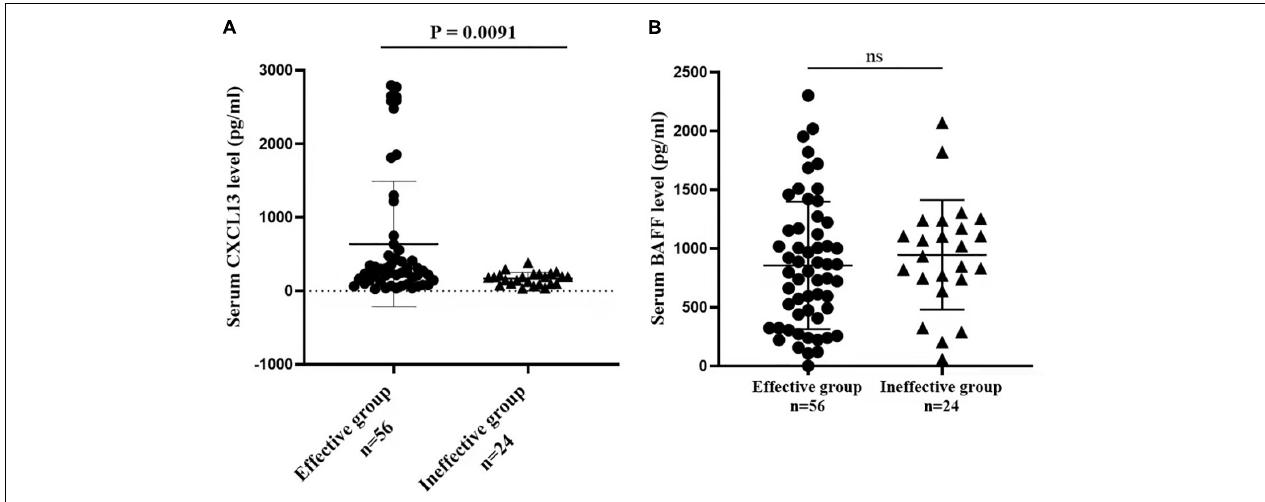
FIGURE 3 | Serum cytokines levels of CXCL13 and BAFF between the effective and ineffective groups. (A) The serum CXCL13 levels are significantly up-regulated in the effective group than the ineffective group ( P < 0.01). (B) No statistical difference is observed in serum BAFF levels between the two groups ( P > 0.05). CXCL13, C-X-C motif ligand 13; BAFF, B cell-activating factor; AR, allergic rhinitis; SCIT, subcutaneous immunotherapy.